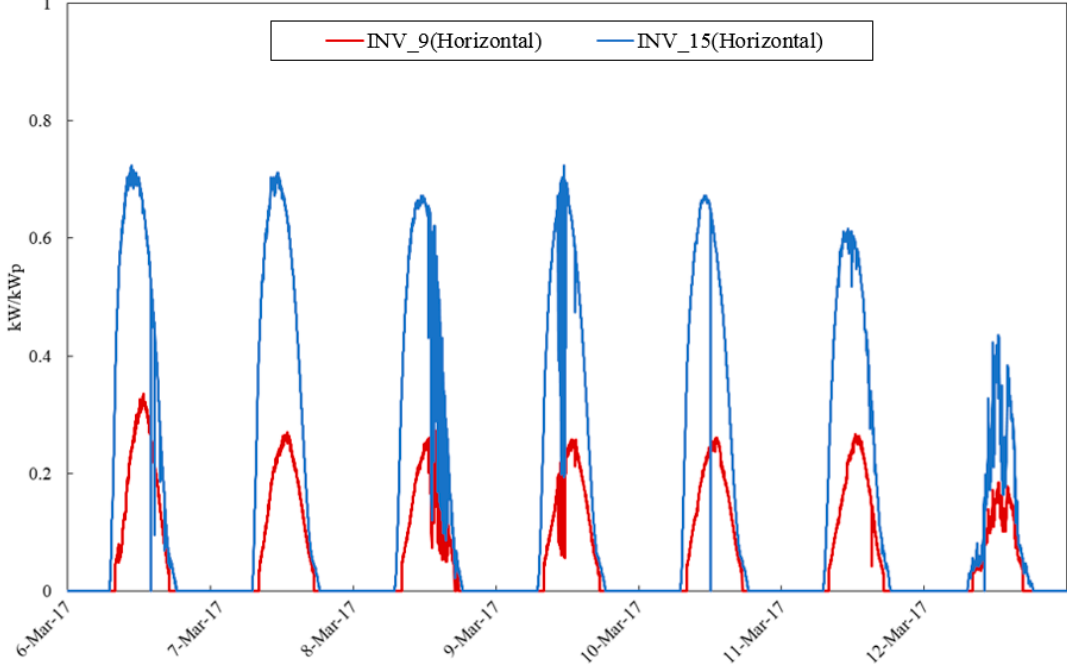
Figure 17. Comparison of energy production per kWp between horizontal BIPV systems (Inv-9 and Inv-15).